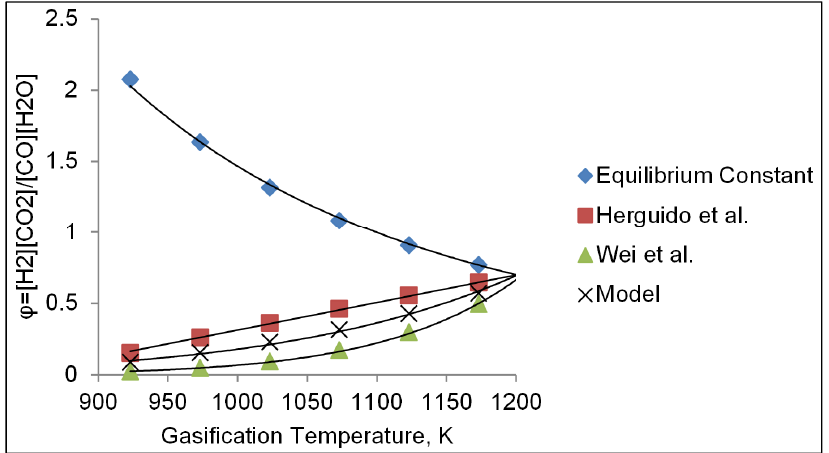
Figure 4. The steam-gas shift reaction equilibrium constant at different